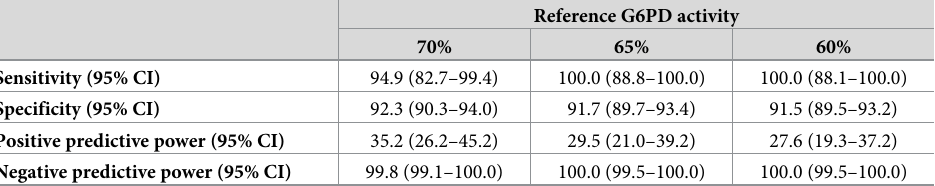
Table 5. Diagnostic performance of the 6.0 U/g Hb threshold on the STANDARD G6PD Test for all females on capillary specimens (n = 922). The sensitivity, specificity, and predictive power for all females with less than 70%, 65%, and 60% activity are